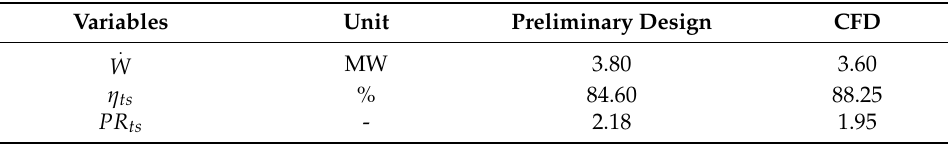
Table 5. Results of the preliminary design and